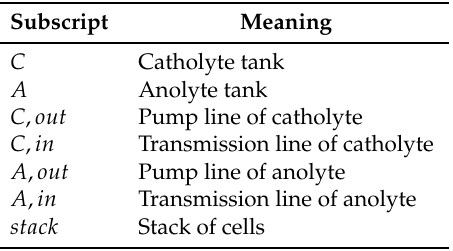
Table 8. Subscripts of temperature